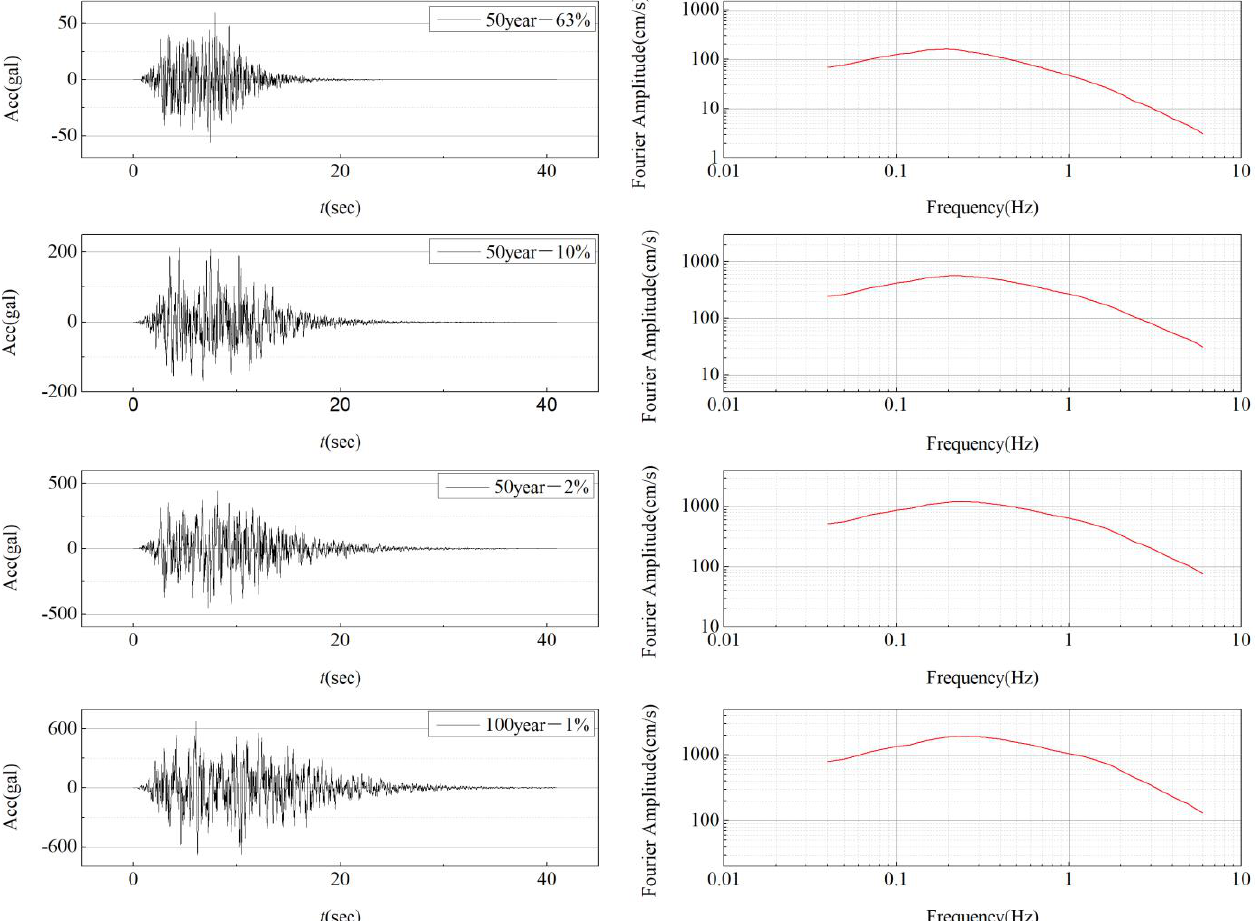
Figure 3. Ground motions under different